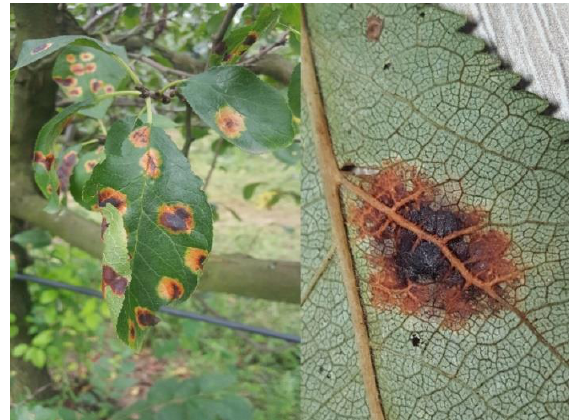
Figure 2. Symptoms caused by Polystigma rubrum on leaves of cultivar ‘Čačanska lepotica’.